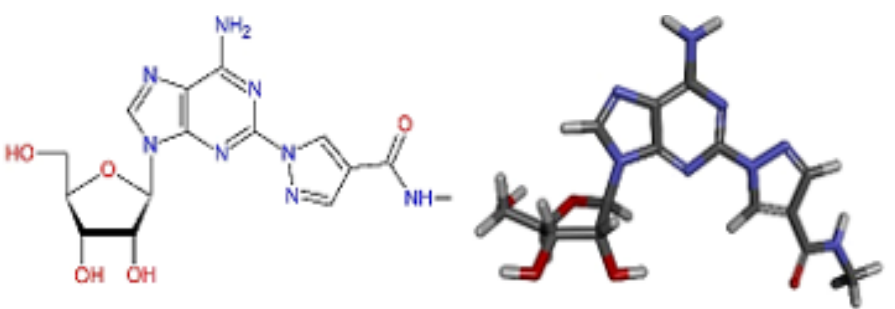
Figure 7. Structure of Regadenoson (CVT3146), developed by Astellas Pharma and commercially